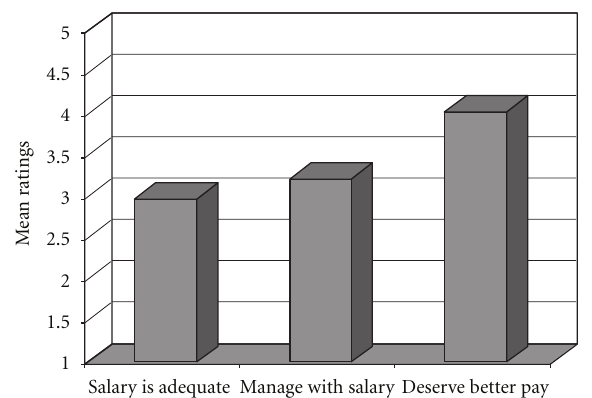
Figure 3: Mean ratings (1 = strongly disagree to 5 = strongly agree) for salary